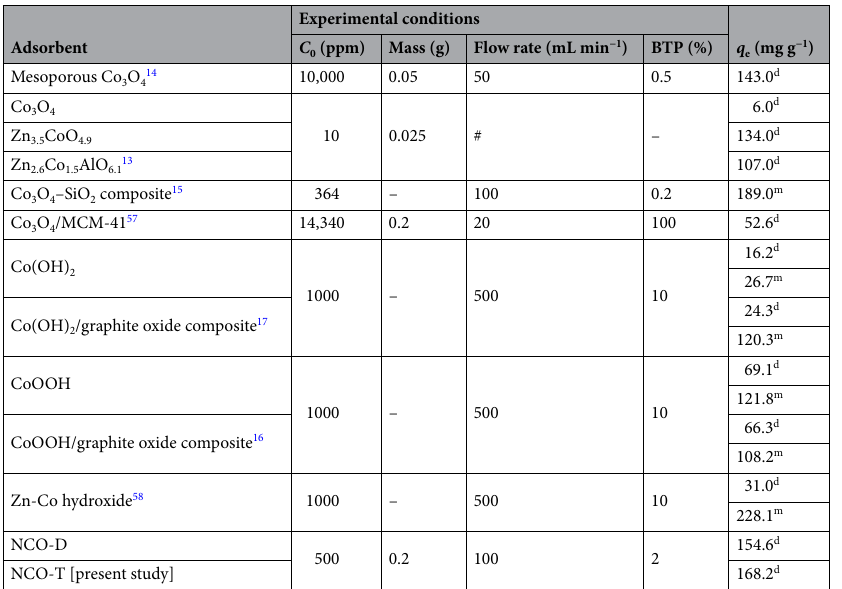
Table 1. The adsorption capacity of cobalt-based adsorbents at room temperature. # Static condition with 20 L of gas equilibrated for 24 h; d Dry condition; m Moist condition.